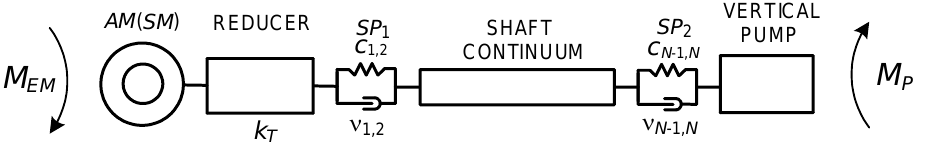
Figure 2. Basic scheme of the pumping system. Figure 2 contains the following nomenclature: M EM — electromagnetic torque of the